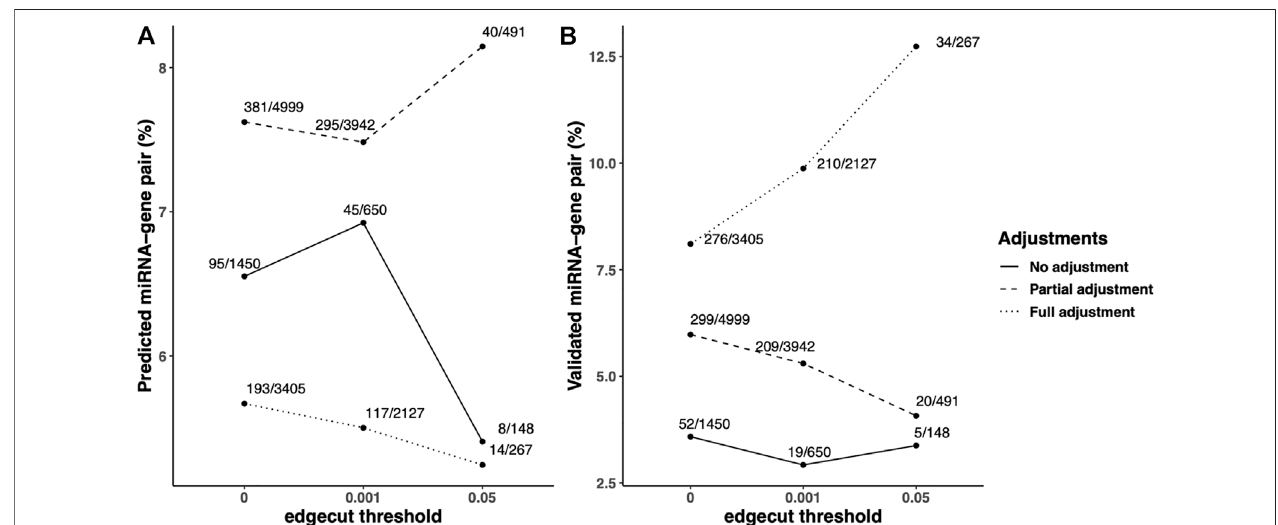
FIGURE 3 | Predicted/validated miRNA – mRNA pairs percentage in the identi fi ed FEV 1 pp-networks with different adjustment strategies. Scaled SmCCNet were applied on the unadjusted, partially adjusted or fully adjusted miRNA and mRNA data with the FEV 1 pp phenotype. To compare the quality of FEV 1 pp-associated networks, the pairs of miRNA and mRNA (gene) with negative correlation in the identi fi ed networks were queried in multiple microRNA/target databases, including predicted microRNA-target databasesand validated microRNA-target databases. The queries were performed withthe “ multiMiR ” R package asdiscussed in the Methods. (AandB) Theratioofpredicted (A) orvalidated (B) pairsindatabasesandtotalpairsintheconstructednetworks.Weapplied0.001and0.05edgethresholds to fi lter weak edges between miRNAs and mRNAs, the ratio of predicted miRNA – mRNA in unadjusted, partially adjusted, and fully adjustment resulted networks were updated